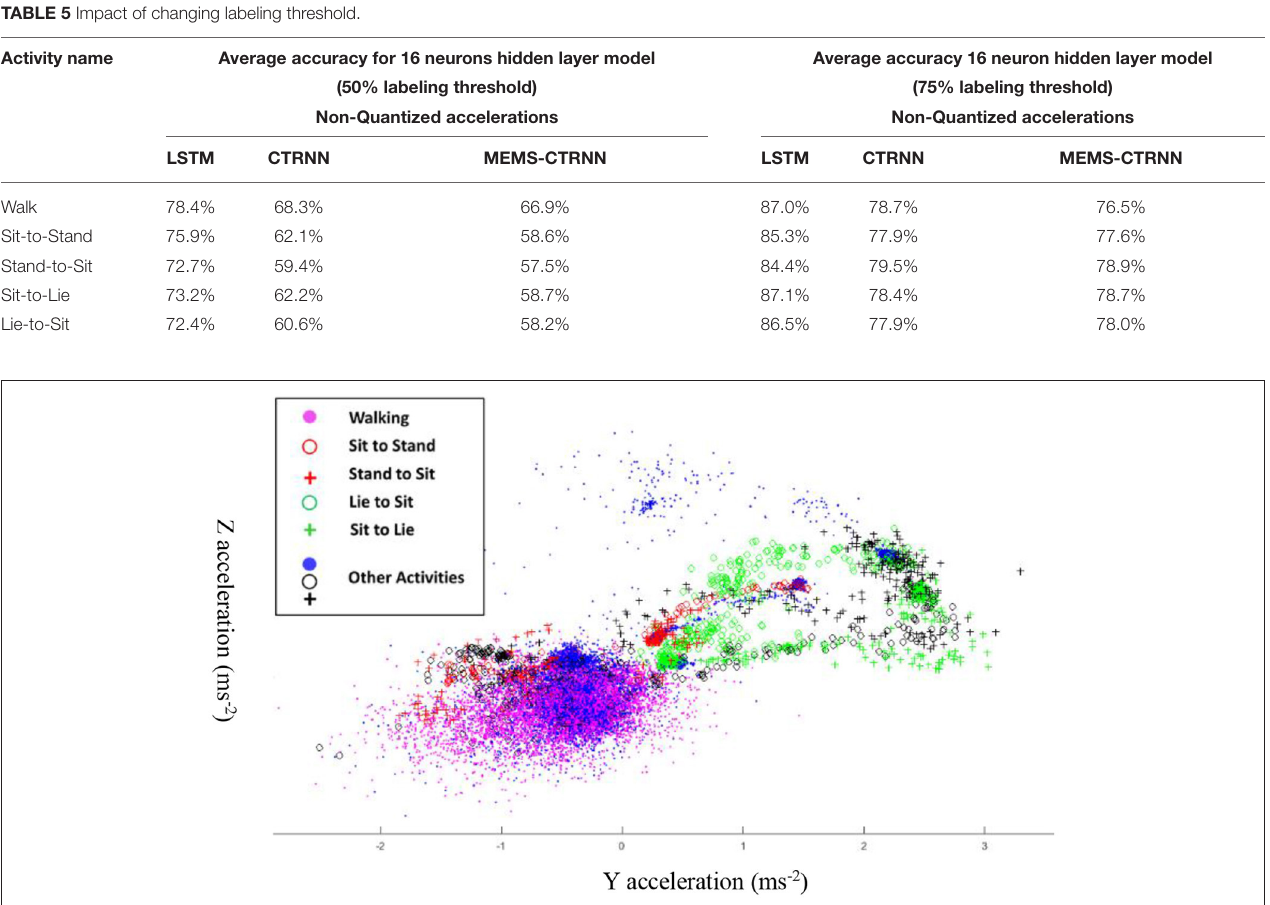
FIGURE 4 | Clusters of activity observations on the YZ